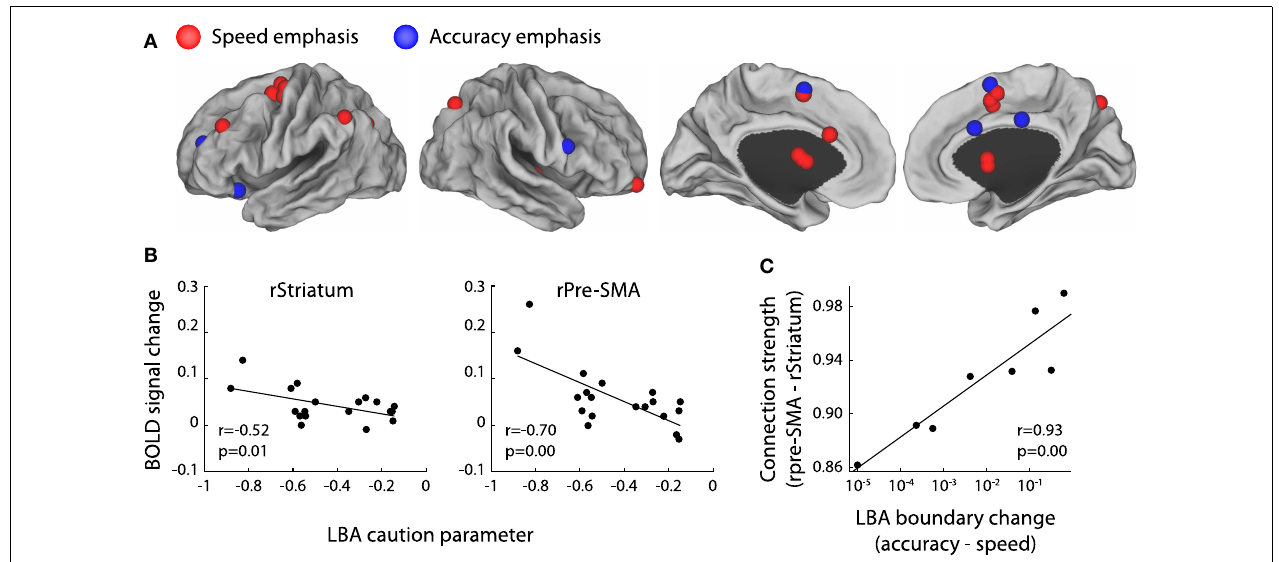
RDM task, the BOLD response increases in the right Pre-SMA and the right Striatum in the speed versus the accuracy condition.These BOLD response changes are associated with decreases in the response caution parameter, which is quantified by boundary changes in the LBA model. Figure modified from Forstmann et al. (2008). (C) The strength of structural connections between the Pre-SMA and the Striatum in individual subjects correlate with the changes of the LBA decision boundary between the speed and the accuracy condition. Figure modified from Forstmann et al.